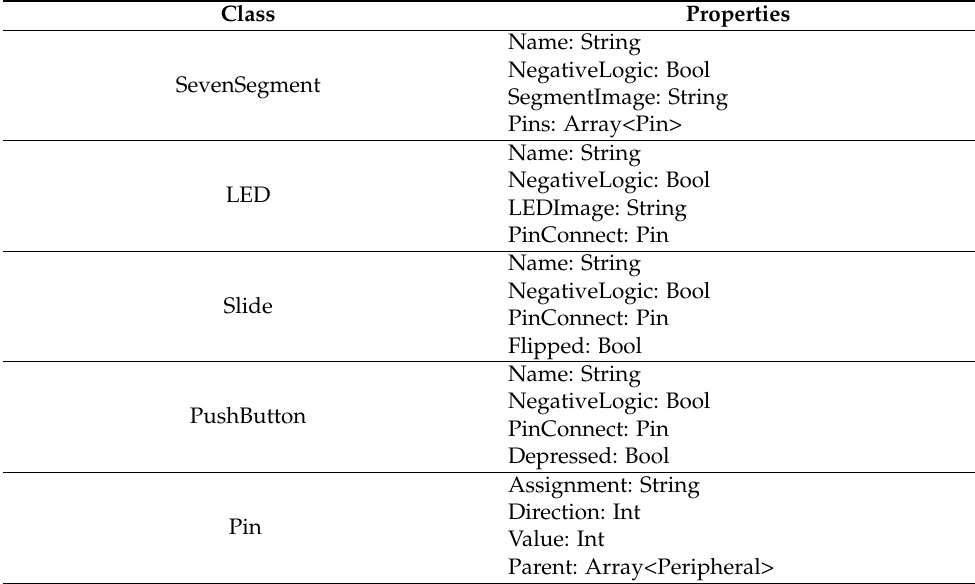
Table 1. Various class implementations in the user